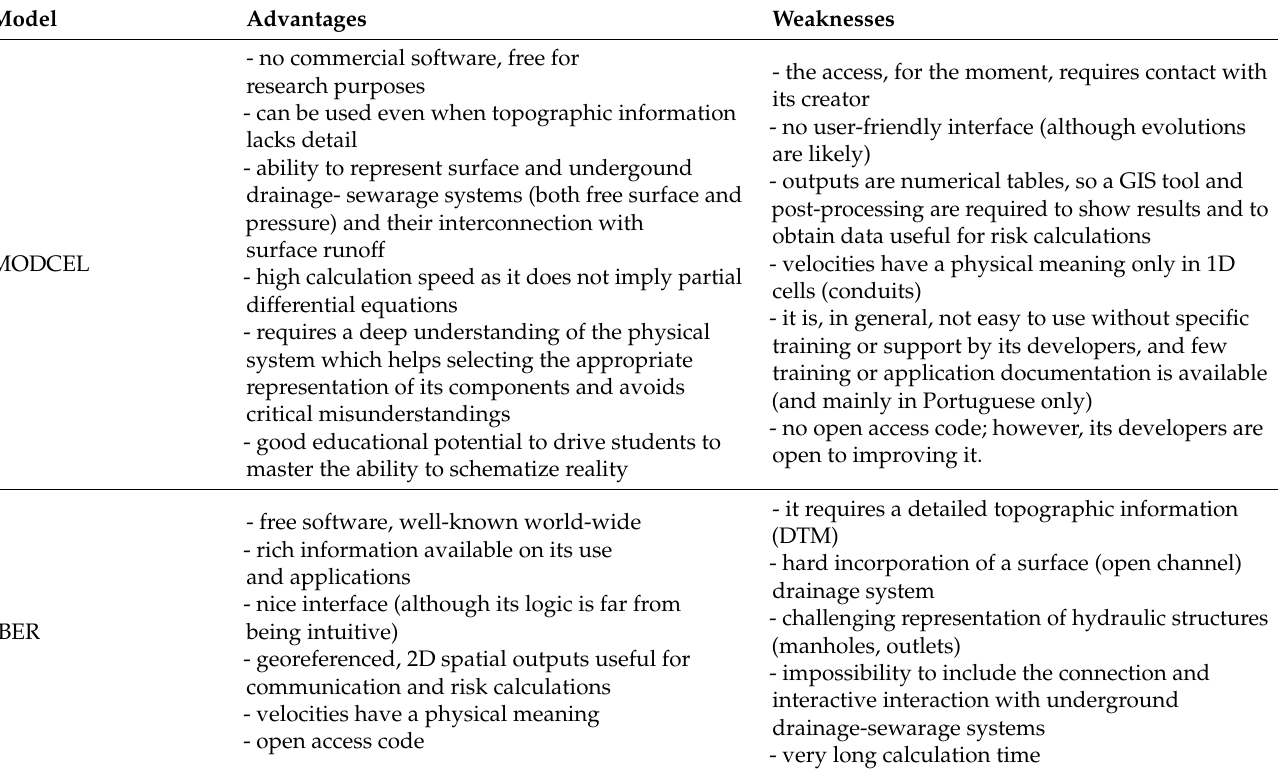
Table 6. Advantages and limitations of the MODCEL and IBER